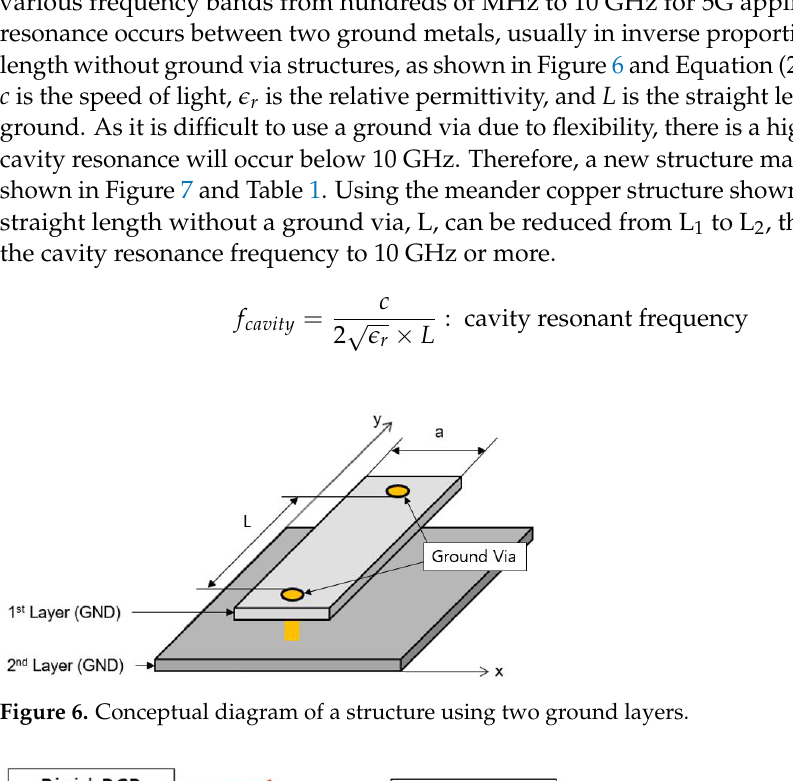
Figure 5. Conceptual diagram of signal transmission and reflection in case of impedance disconti- nuity.